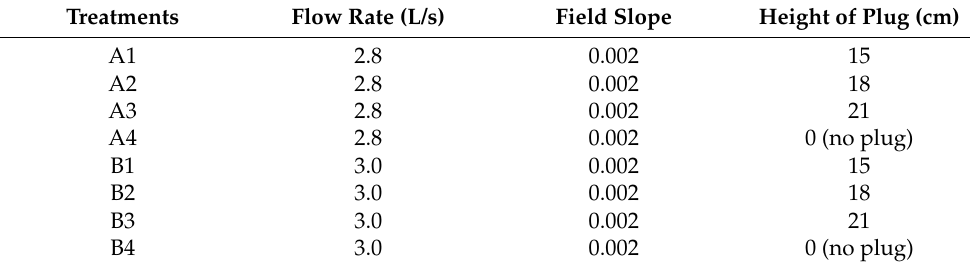
Table 1. Simulation treatments and working conditions.